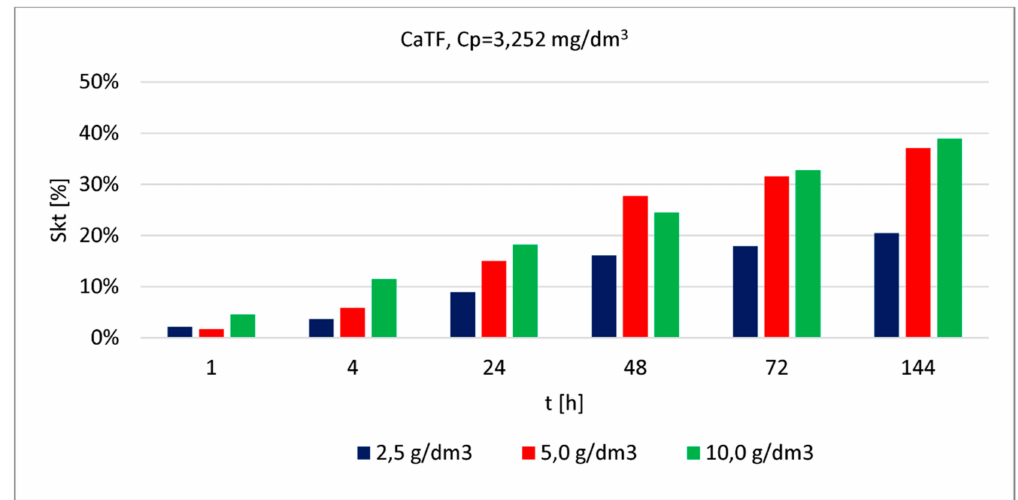
Figure 5. Phosphate removal e ffi cacy (3.252 [mg / dm 3 ]) by CaTF (dose: 2.5; 5.0; 10.0 [g / dm 3 ]) at di ff erent contact time steps.